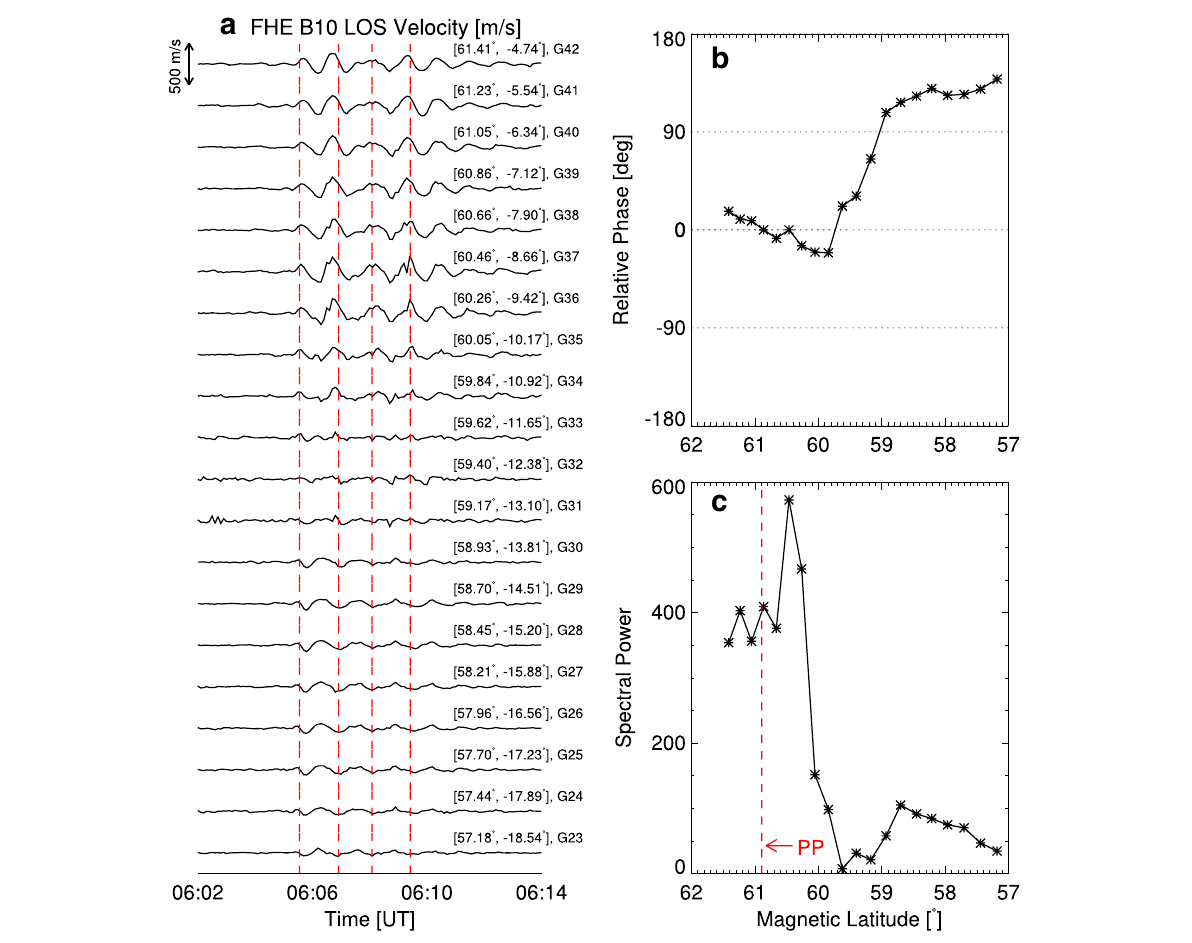
Fig. 34 The FHE beam 10 LOS velocity as a function of time and results of a spectral analysis. a The FHE beam 10 LOS velocity as a function of time for a number of different range gates. b The relative phase from the spectral analysis as a function of latitude while c shows the amplitude from the spectral analysis. Note the red dashed line in b which gives the estimated position of the plasmapause. Reproduced from Fig. 12 of Shi et al.